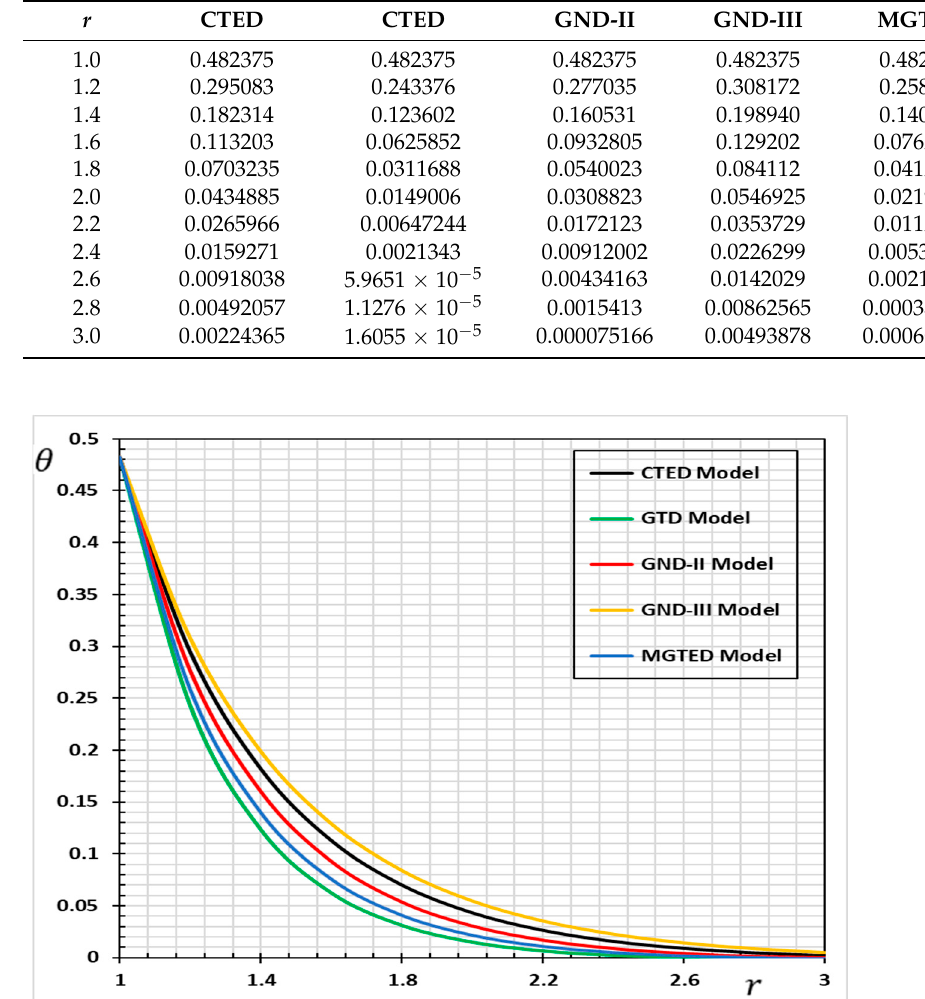
Figure 1. The temperature 𝜃 for different thermo-diffusion